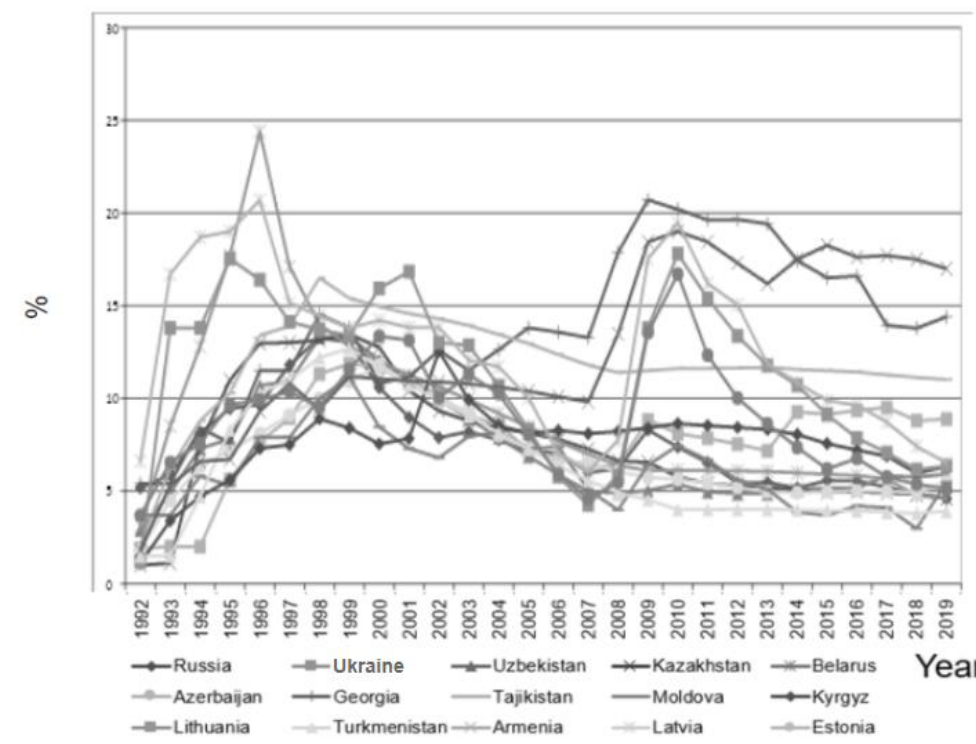
Figure 4. The annual unemployment rate in the 15 post-Soviet countries in 1992 – 2019.